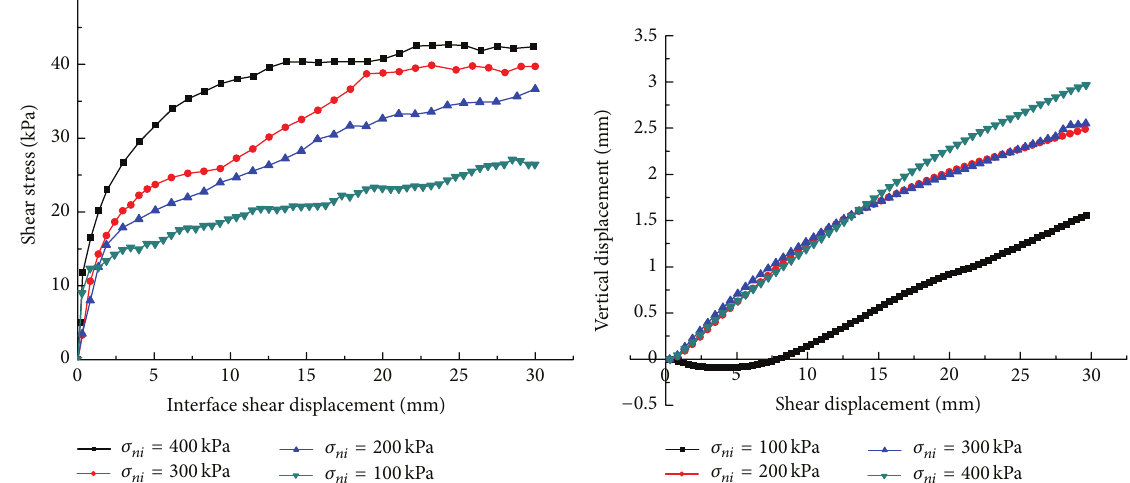
Figure 7: Test results for the interface between plate #1 and clay (applied normal stress of 100kPa).